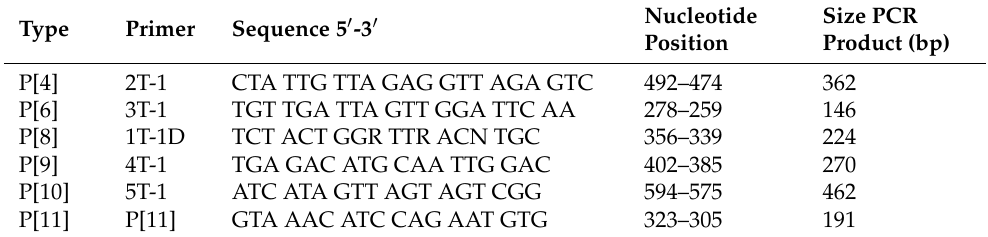
Table 4. P-Typing PCR